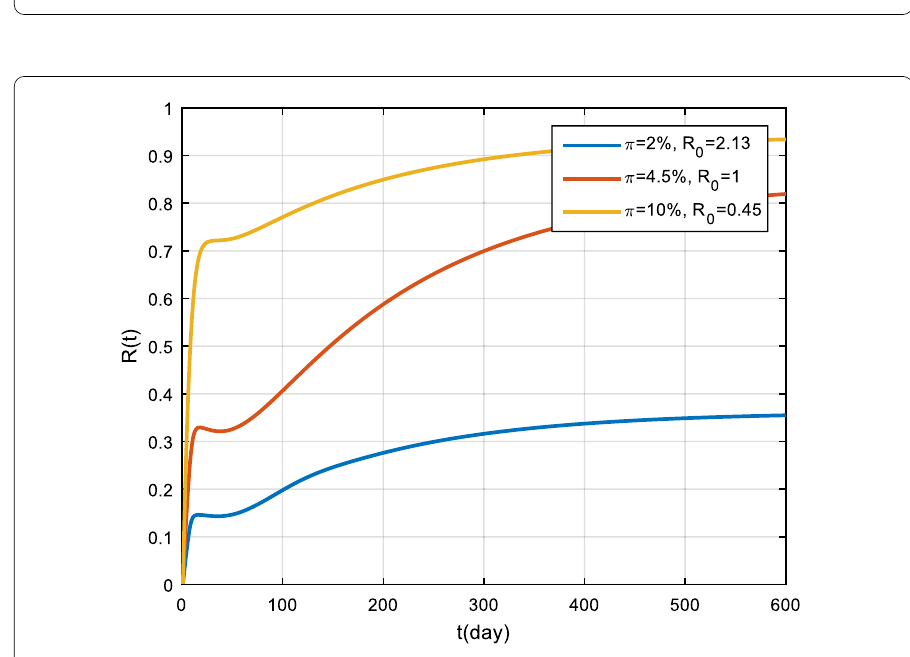
Figure 12 Variation in the number of infected population for different values of